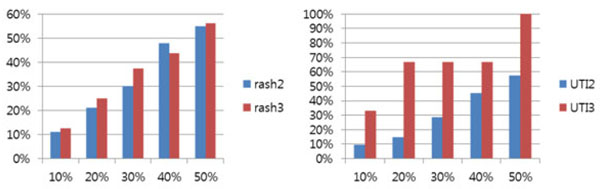
Evaluation of our hypothesis for rash and UTI. The x axis is the top n% for the total process scores. The y axis is percentage of processes with scores greater than the top n% (x axis) threshold of the total processes scores.